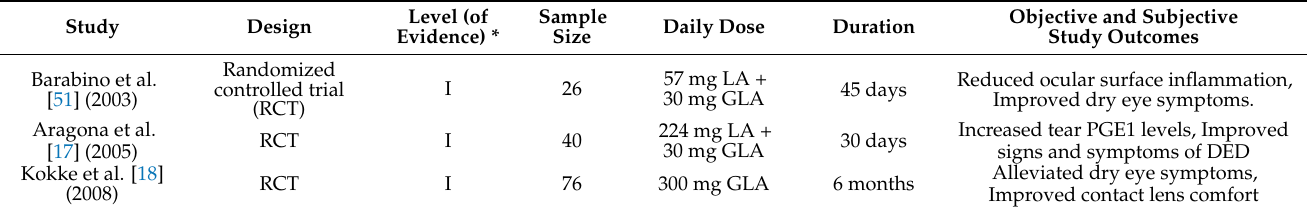
Table 1. Summary of the studies on the efficacy of ω 6 PUFAs on